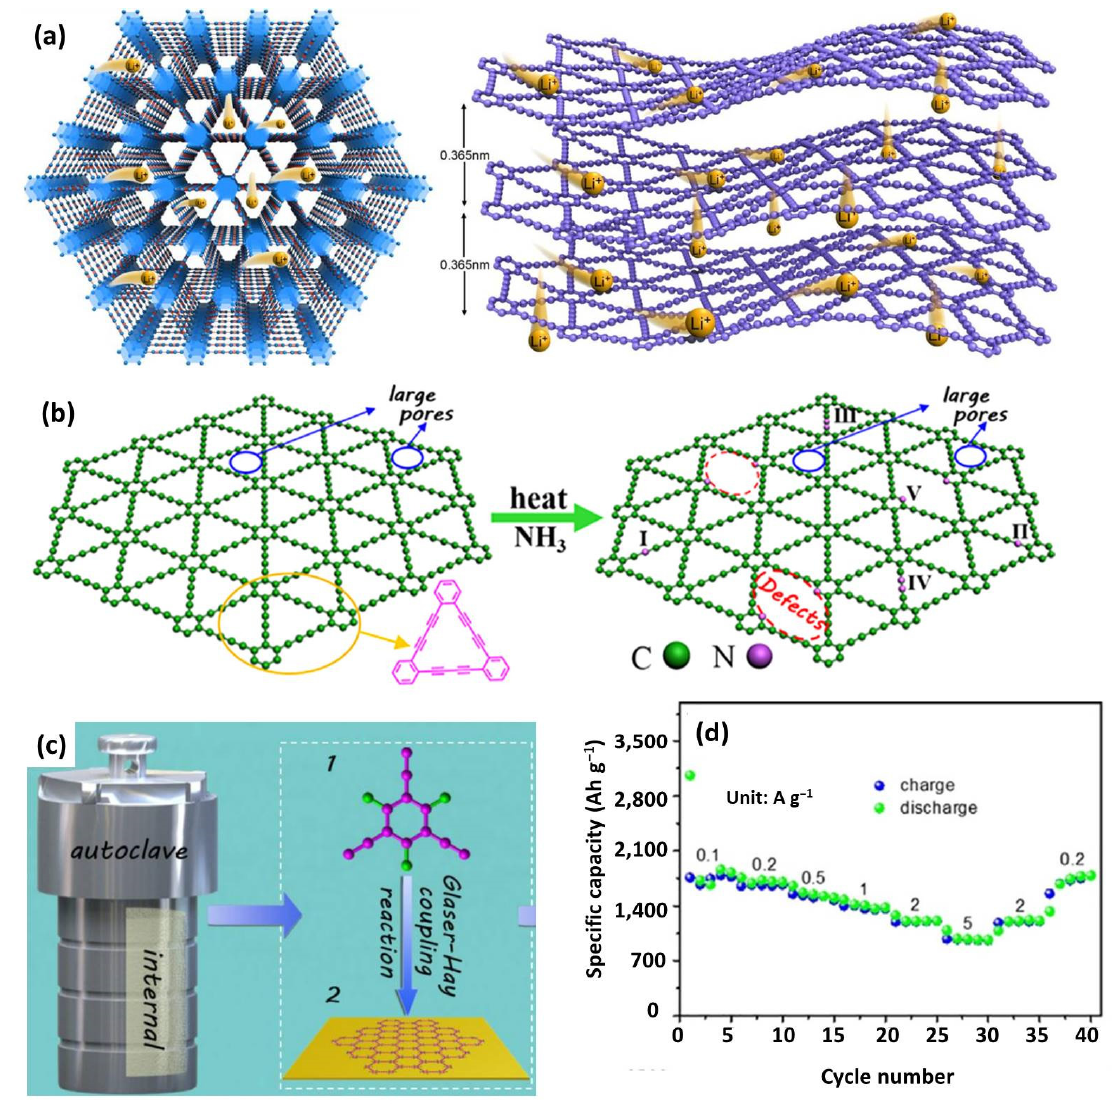
Figure 11. ( a ) Scheme of lithium diffusion in GDY layers. Reproduced with permission from Ref. [183]. Copyright 2016, Elsevier. ( b ) Schematic illustration of preparation of N-GDY. Reproduced with permission from Ref. [149]. Copyright 2019, Wiley-VCH. ( c ) The schematic of synthesis of F-GDY; ( d ) Rate capability of F-GDY. Reproduced with permission from Ref. [150]. Copyright 2018, Wiley-VCH.